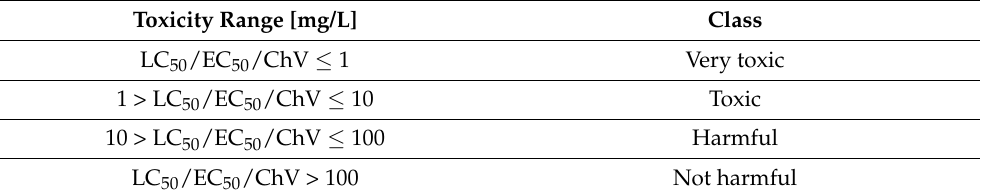
Table 4. Toxicity classification according to the Globally Harmonized System of Classification and Labelling of Chemicals (GHS). (United Nations, 2011).